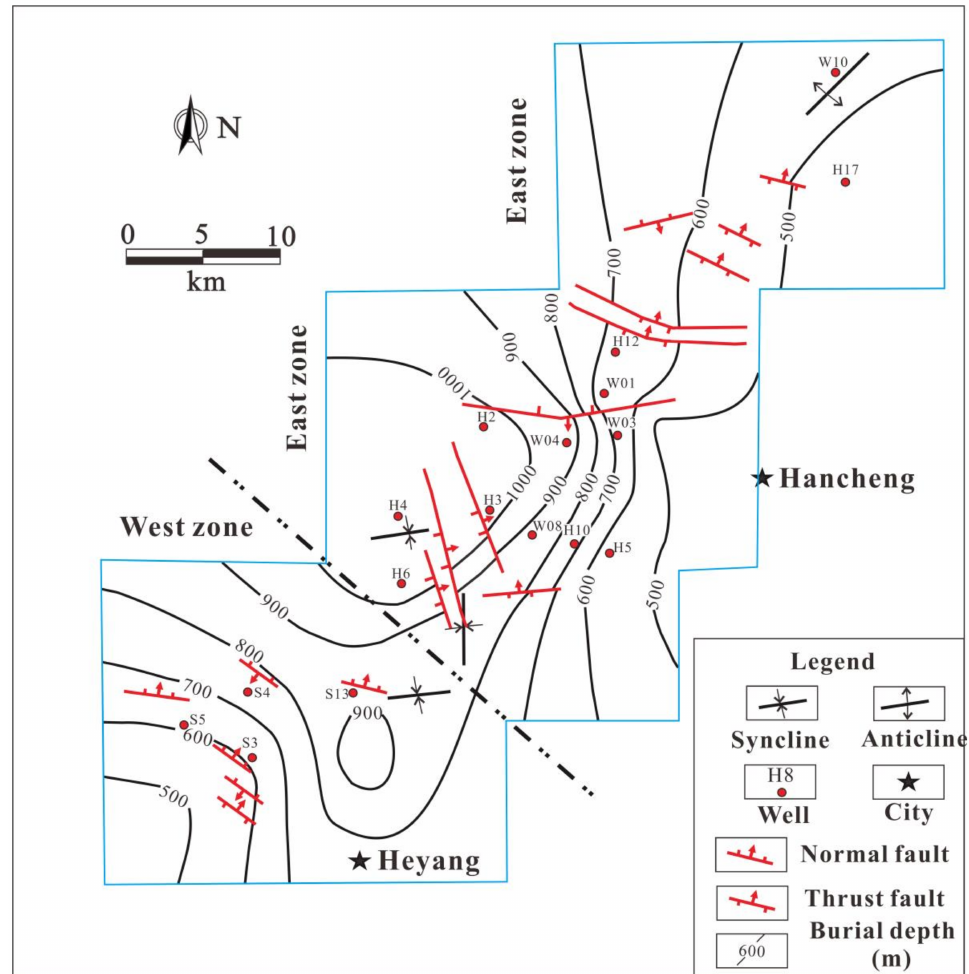
Figure 8. Burial depth distribution of the No.5 coal seam in the Weibei Field.